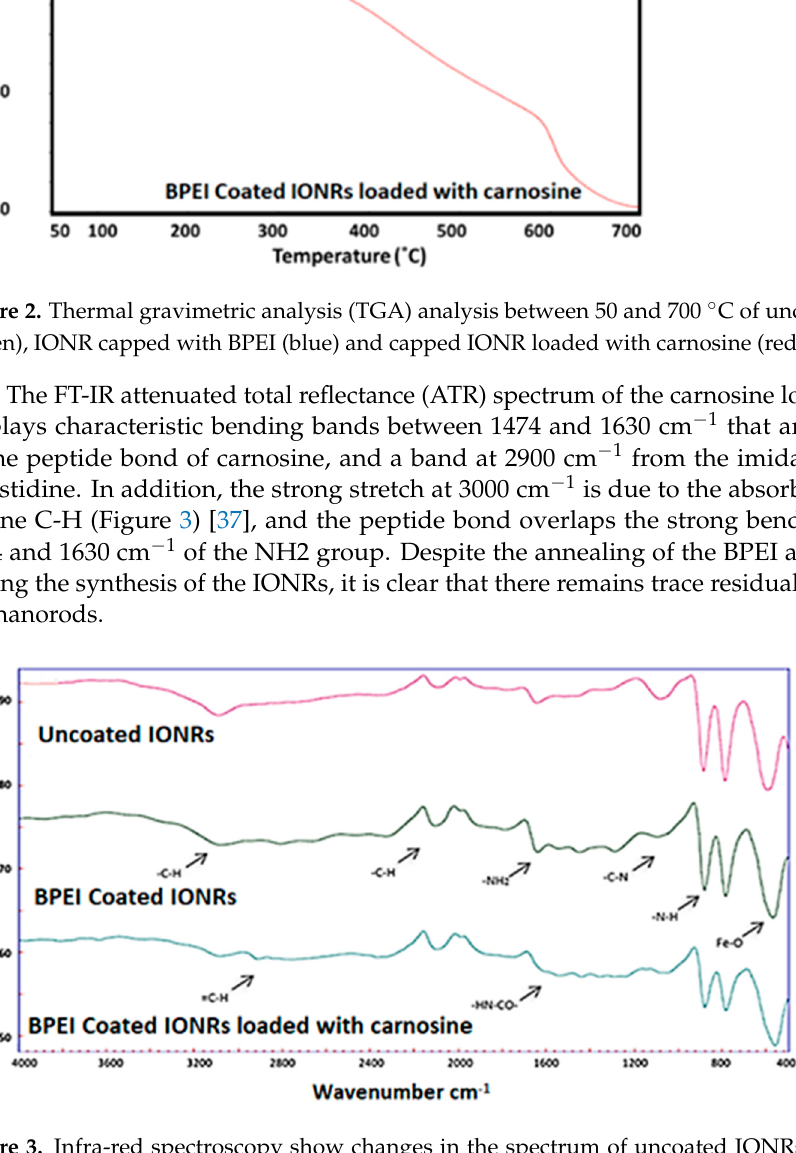
Figure 3. Infra ‐ red spectroscopy show changes in the spectrum of uncoated IONRs (red), capped with BPEI (green) and capped IONR loaded with carnosine (blue). Arrows indicate the IONR capped with BPEI (green) and capped IONR loaded with carnosine (blue). Arrows representative frequencies from the imidazole ring of L-histidine and peptide indicate the representative frequencies from the imidazole ring of L ‐ histidine and peptide bond.